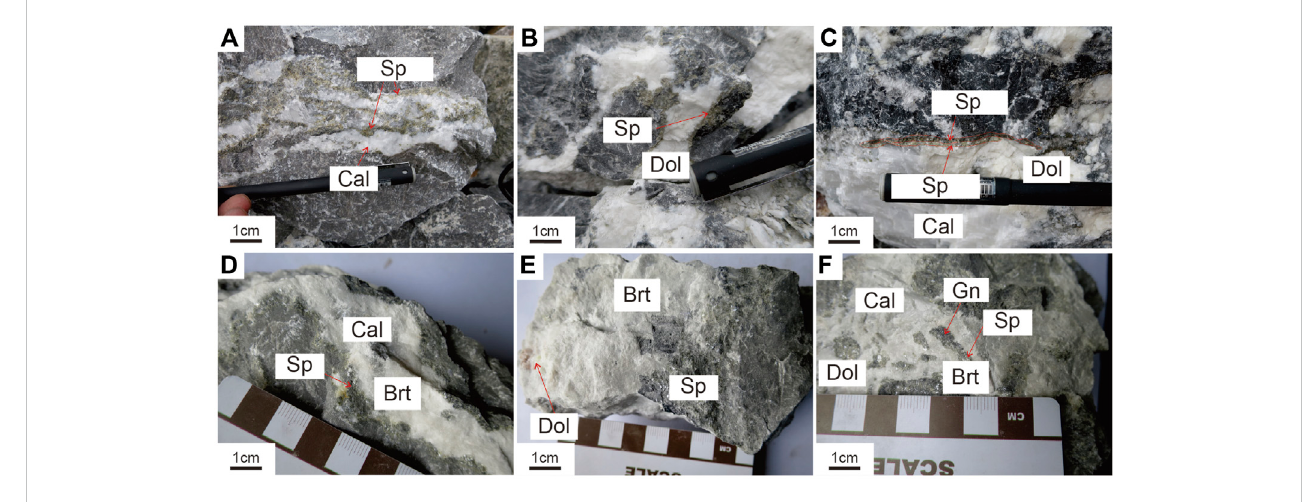
Photos of ore types in the Huayuan Pb-Zn ore fi eld.